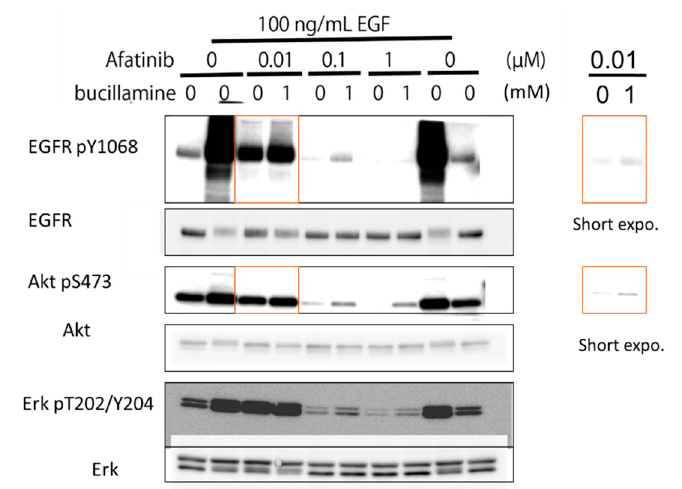
Figure 4. Bucillamine inhibited afatinib-mediated inhibition of EGFR autophosphorylation and downstream signaling. A431 cells expressing endogenous WT EGFR were pre-incubated with 0.01–1 μ M afatinib in the presence or absence of 1 mM bucillamine. Then, 100 ng/mL of EGF was added to the culture medium. After 15 min incubation, cell lysates were prepared and analyzed by Western blotting with specific antibodies, as indicated. Shorter-exposure images are shown on the right. EGFR, epidermal growth factor receptor; WT, wild type.